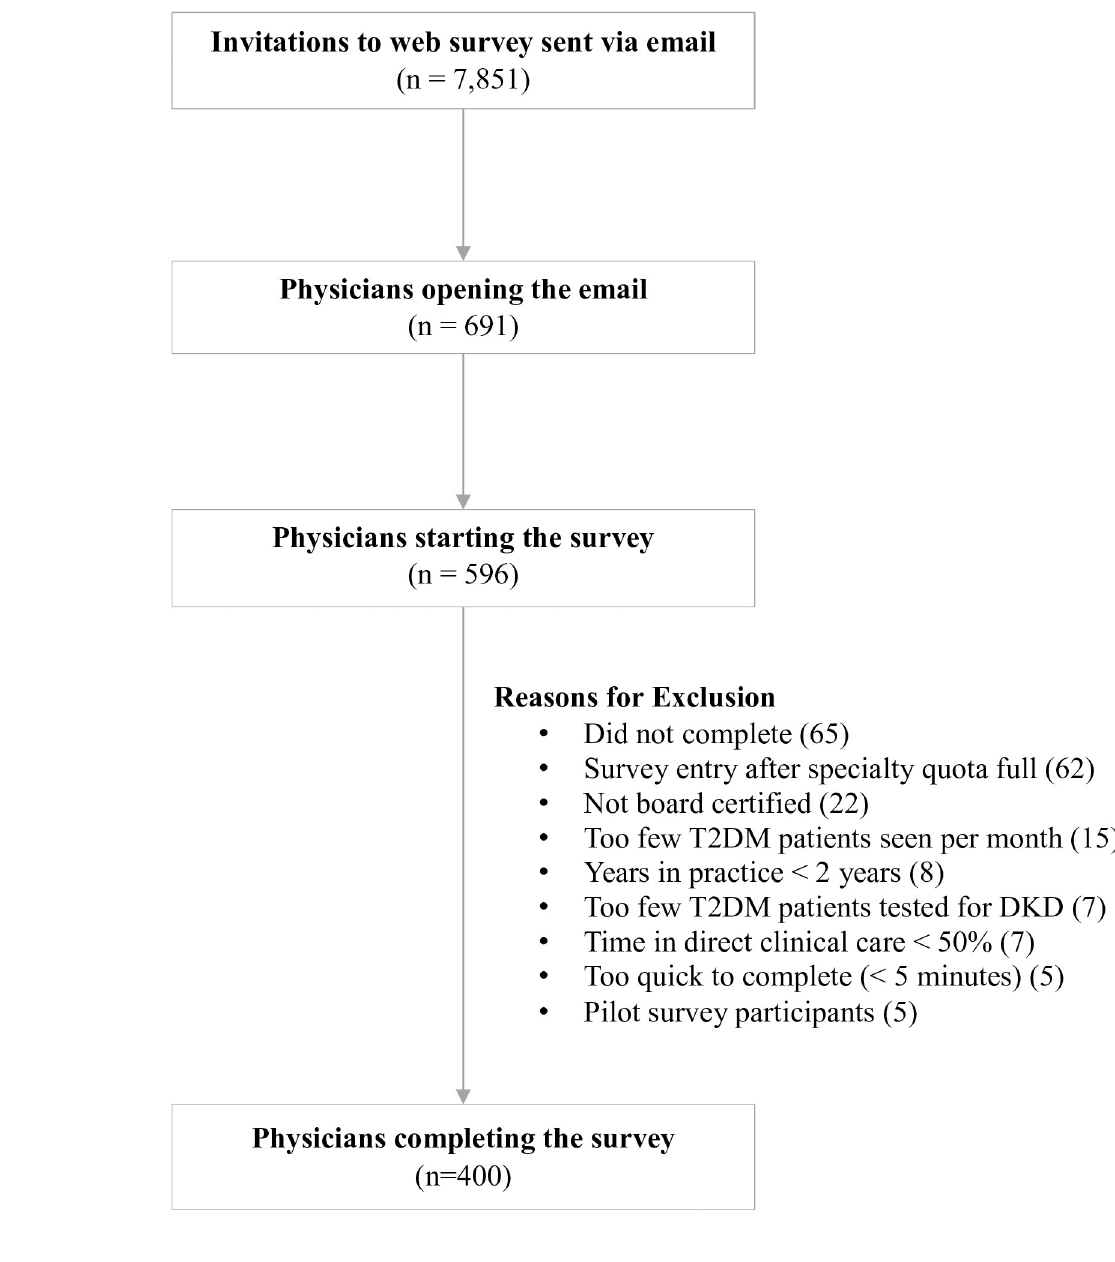
Fig 1. Attrition of survey